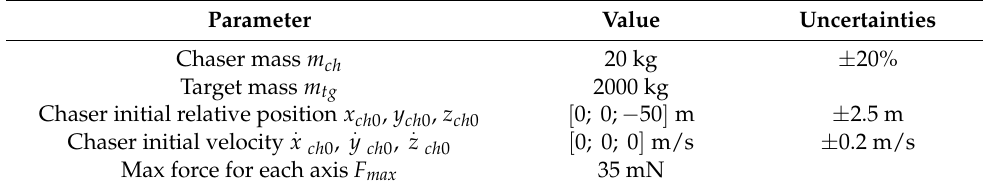
Table 4. Initial conditions of the simulation with the boundaries of